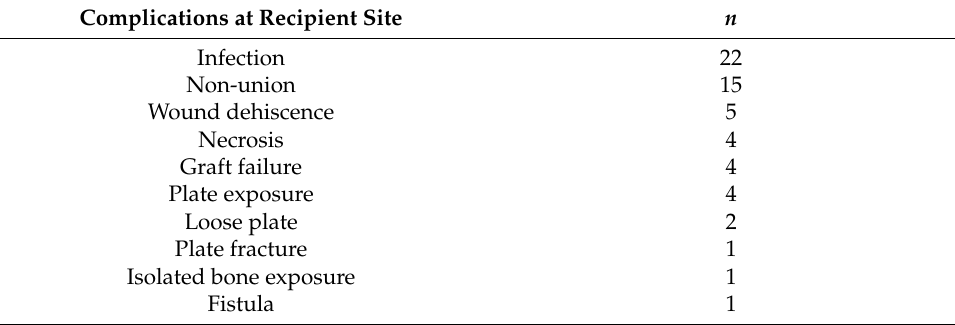
Table 2. Overview of the Type of Complications